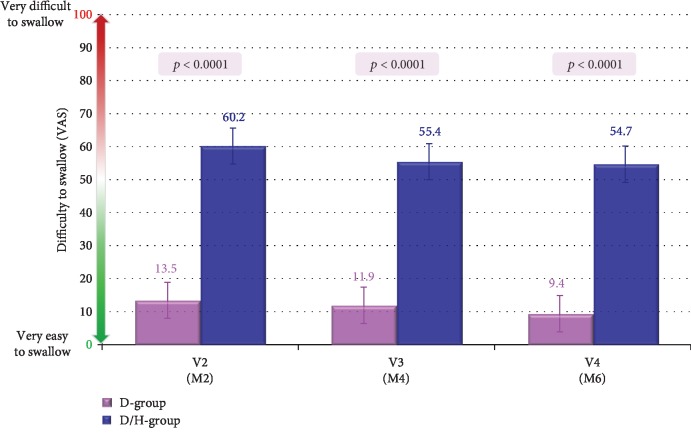
Difficulty to swallow assessed with VAS (results are given as adjusted means ± SE).